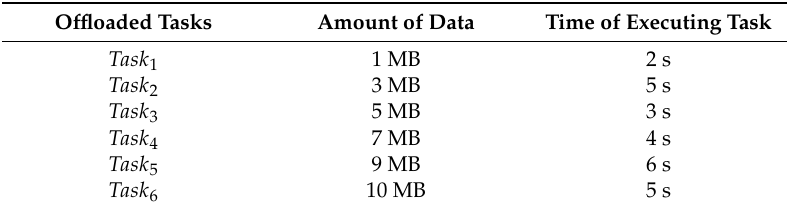
Table 1. The parameters of offloaded tasks in following experiments.